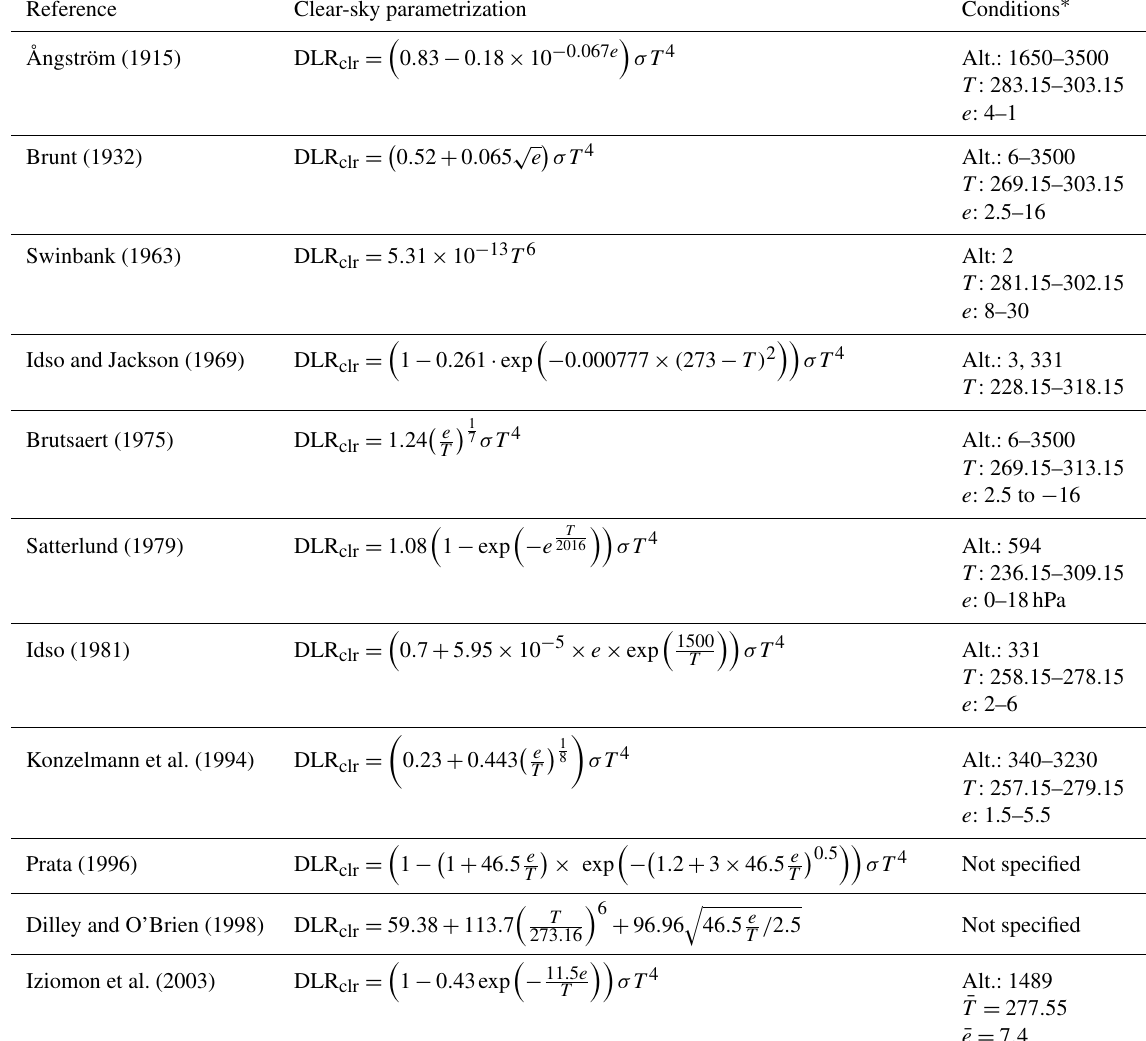
Table 2. Details of 11 clear-sky DLR parametrizations and their specific